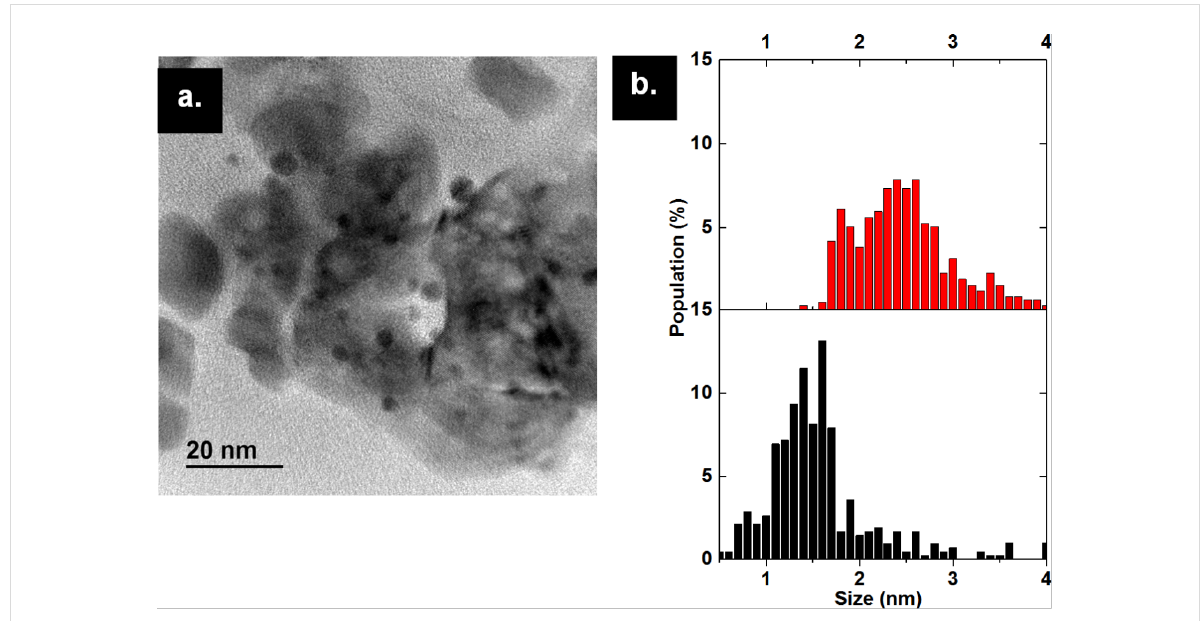
Figure 8: (a) TEM image of (A 300 ) 3 after the third catalytic cycle. (b) Comparison of the size distribution of (A 300 ) 3 in red and (A 300 ) before the catalyt- ic test in black.